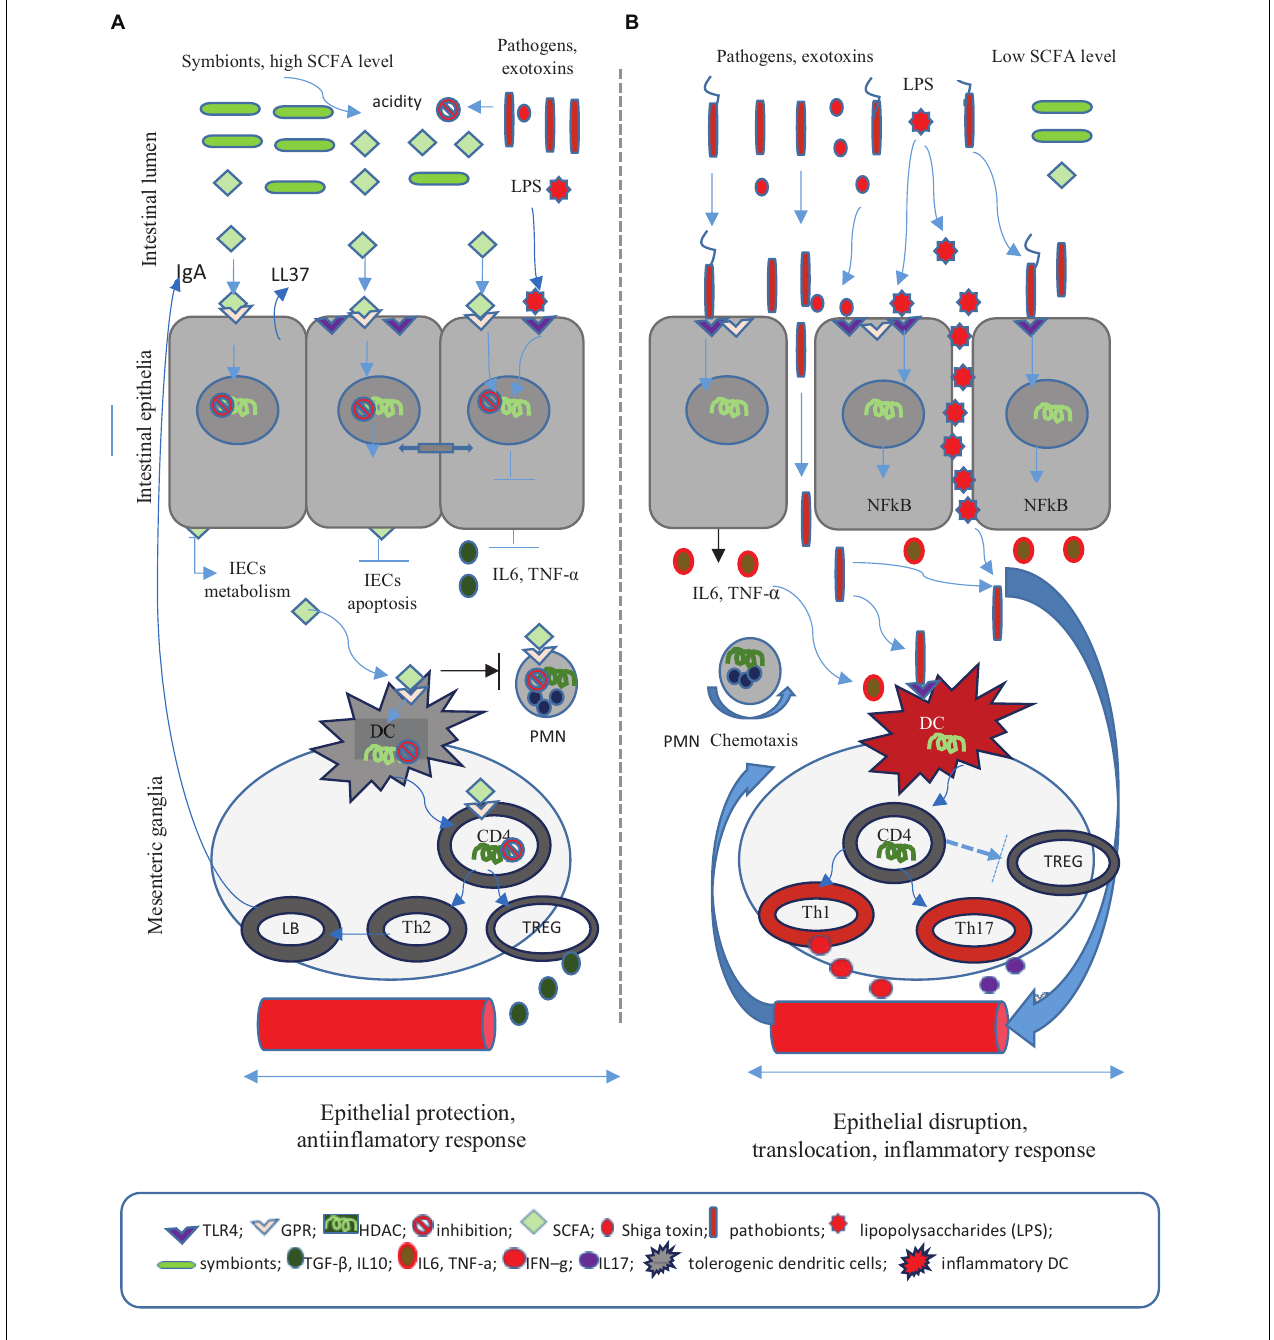
FIGURE 2 | The role of short chain fatty acids (SCFA) in the anti-infectious defense. (A) SCFA are fermentation products of the commensal flora and exert anti-inflammatory and trophic roles on the intestinal epithelial cells (IECs). SCFA elicit effects on IECs metabolism increasing colonic acidity and preventing the colonization with pathogenic germs. SCFA play a significant role in the preservation of tight epithelial junctions through the activation of HIF factor and by decreasing enterocyte apopotosis. As a result SCFA decrease epithelial permeability. At a cellular level SCFA activate specific G protein-coupled receptors (GPR), modulate the chromatin through histone deacetylase (HADC) inhibition, supress the nuclear factor ( NF )- κ B and reduce the release of pro-inflammatory cytokines (IL6, TNF- α ). SCFA regulate the inflammatory response by promoting tolerogenic dendritic cells (DCs), IL-10-producing T-helper cells (TREG), and Th2 response including B- cell IgA production. The immune role of SCFA relies on their ability to induce an anti-inflamatory response and to stimulate antimicrobial molecules, namely cathelicidin (LL37) and intestinal IgA. Consequently SCFA offer protection to IEC and decrease the risk of bacterial invasion and toxin translocation. (B) The absence of SCFA leads to epithelial breaches and translocations of bacteria and lipopolysaccharides (LPS). The inflammatory response involves the following: the activation of toll-like receptor 4 (TLR4) by pathogenic flora, HDAC activity, the (NF) - B transcription, DCs stimulation which promotes mesenteric Th1/Th17 cell differentiation, the release of pro-inflammatory cytokines IL6, TNF- α , IFN– γ , IL17, and neutrophil migration.